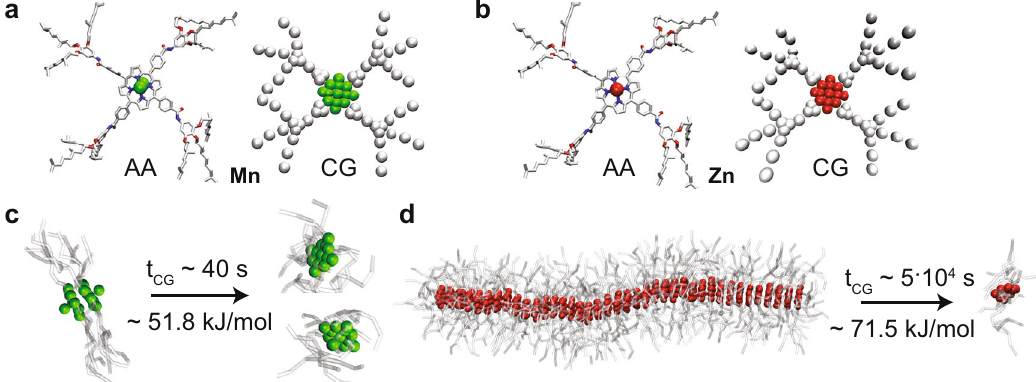
Fig. 4 Molecular modeling. a , b All-atom (AA) and coarse-grained (CG) models for Zn and Mn monomers. The Zn fi ber and the Mn dimer were equilibrated in cyclohexane. c , d The free energy barrier and the CG-time of exchange from the dimer and the fi ber tip obtained from infrequent